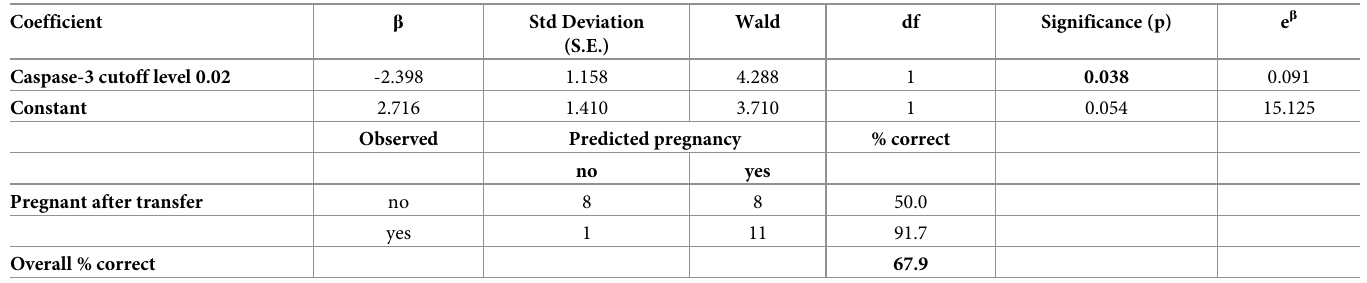
Table 5. Binary logistic regression analysis for predicting pregnancy using a cutoff value of 0.02 for caspase-3 levels.